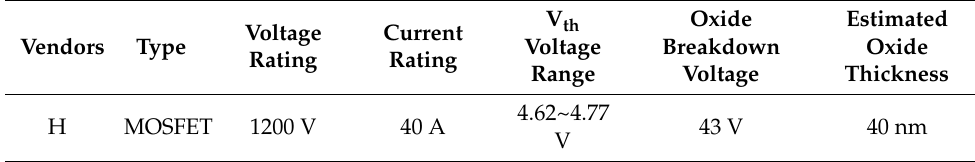
Table 3. Information of commercial SiC MOSFET (Vendor H).